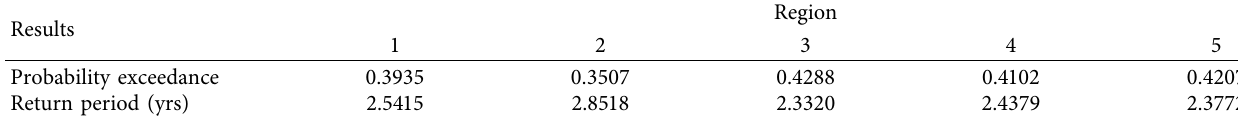
Table 6: Probability of exceedance and return period for the five homogeneous regions.